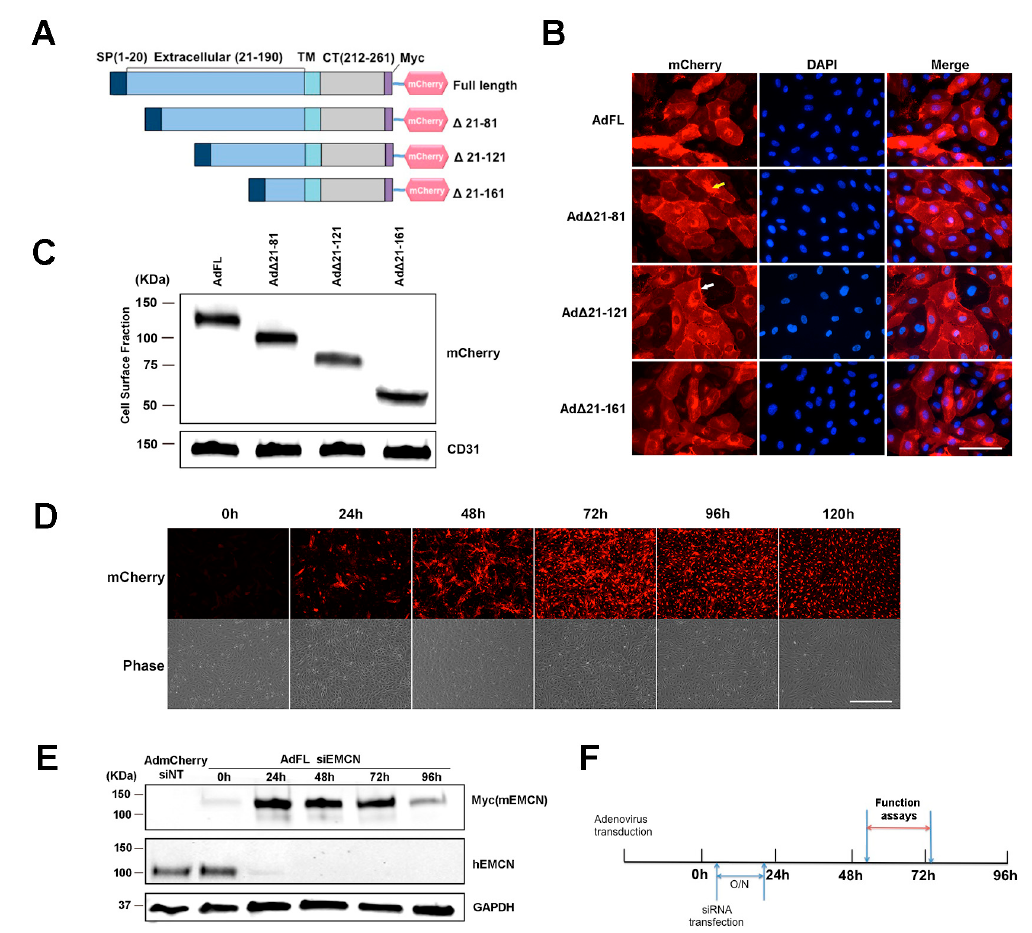
Figure 1. Endomucin (EMCN) mutants: constructs, expression, and experimental design. ( A ) Schematic representation of the full-length (FL) murine EMCN protein and the truncation mutants. SP, signal peptide; TM, transmembrane domain; CT, cytoplasmic tail; mCherry, fluorescence tag. ( B ) Human retinal endothelial cells (HRECs) were transduced overnight with adenoviruses expressing EMCN-truncated mutants. Autofluorescence of mCherry was examined 48 h post-infection. Scale bar: 100 um. Expression of all of the constructs was detected in the cytoplasm (indicated by yellow arrow) as well as on the cell surface (indicated by white arrow). ( C ) Adenoviruses expressing EMCN-truncated mutants were transduced into HRECs, and cell surface proteins were labeled by biotinylation and analyzed by western blot using antibodies against mCherry and CD31. The FL as well as all of the mutants were detected at the cell surface at the expected molecular weights. ( D ) HRECs were transduced with adenoviruses expressing EMCN truncated overnight, and mCherry fluorescence and phase contrast was examined every 24 h. Scale bar: 200 μ m Expression was detected as early as 24 h, peaked at 72 h, and declined thereafter. ( E ) Cells lysates of HRECs in which endogenous hEMCN had been knocked down using siRNA and overexpressing full-length mouse EMCN was collected every 24 h. and protein levels of Myc-tagged (Myc mEMCN) and hEMCN were examined by western blot. GAPDH was used as loading control. Endogenous hEMCN was effectively knocked down at 24–96 h whereas exogenously expressed mEMCN was highly expressed at 24–72 h. ( F ) Experimental design for subsequent studies shows that HRECs were transduced with adenoviruses overexpressing mEMCN mutants, and one day later, endogenous hEMCN was knocked down using siRNA. In vitro functional assays, vascular endothelial growth factor receptor 2 (VEGFR2) internalization and co-IP were conducted 48–72 h post-transfection. We next determined if the different mEMCN mutants could rescue VEGF-induced migration, tube formation, and/or cell proliferation in HRECs lacking endogenous EMCN. As expected,